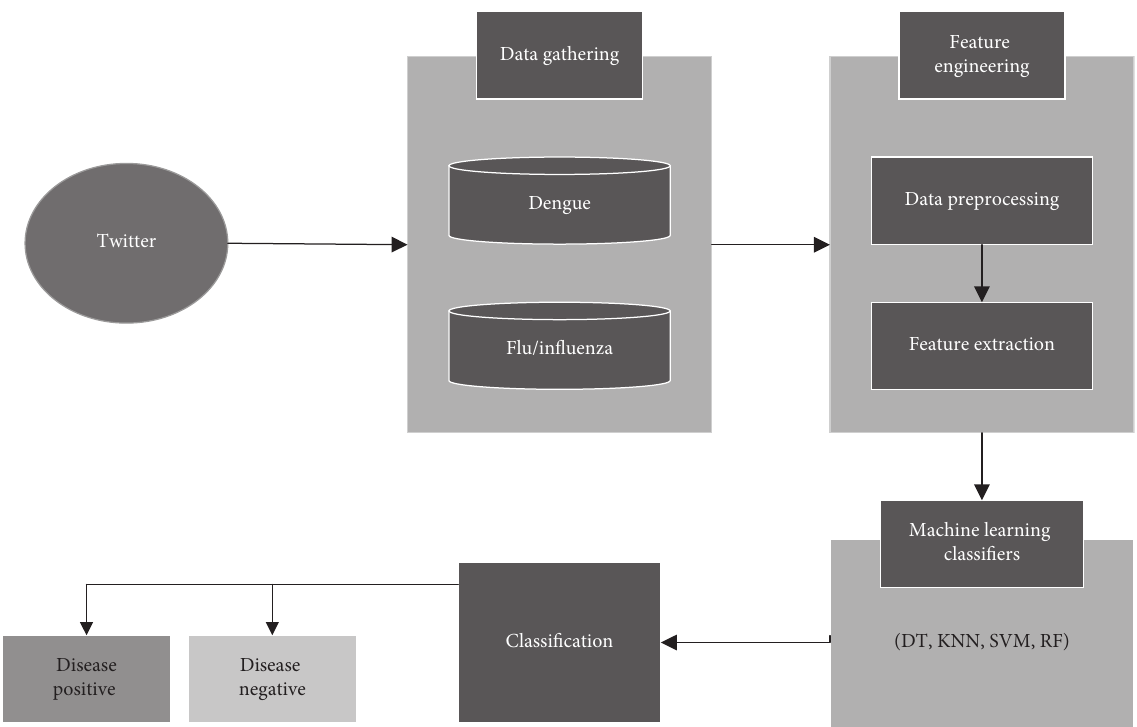
Figure 1: Proposed seasonal outbreaks classification methodology.